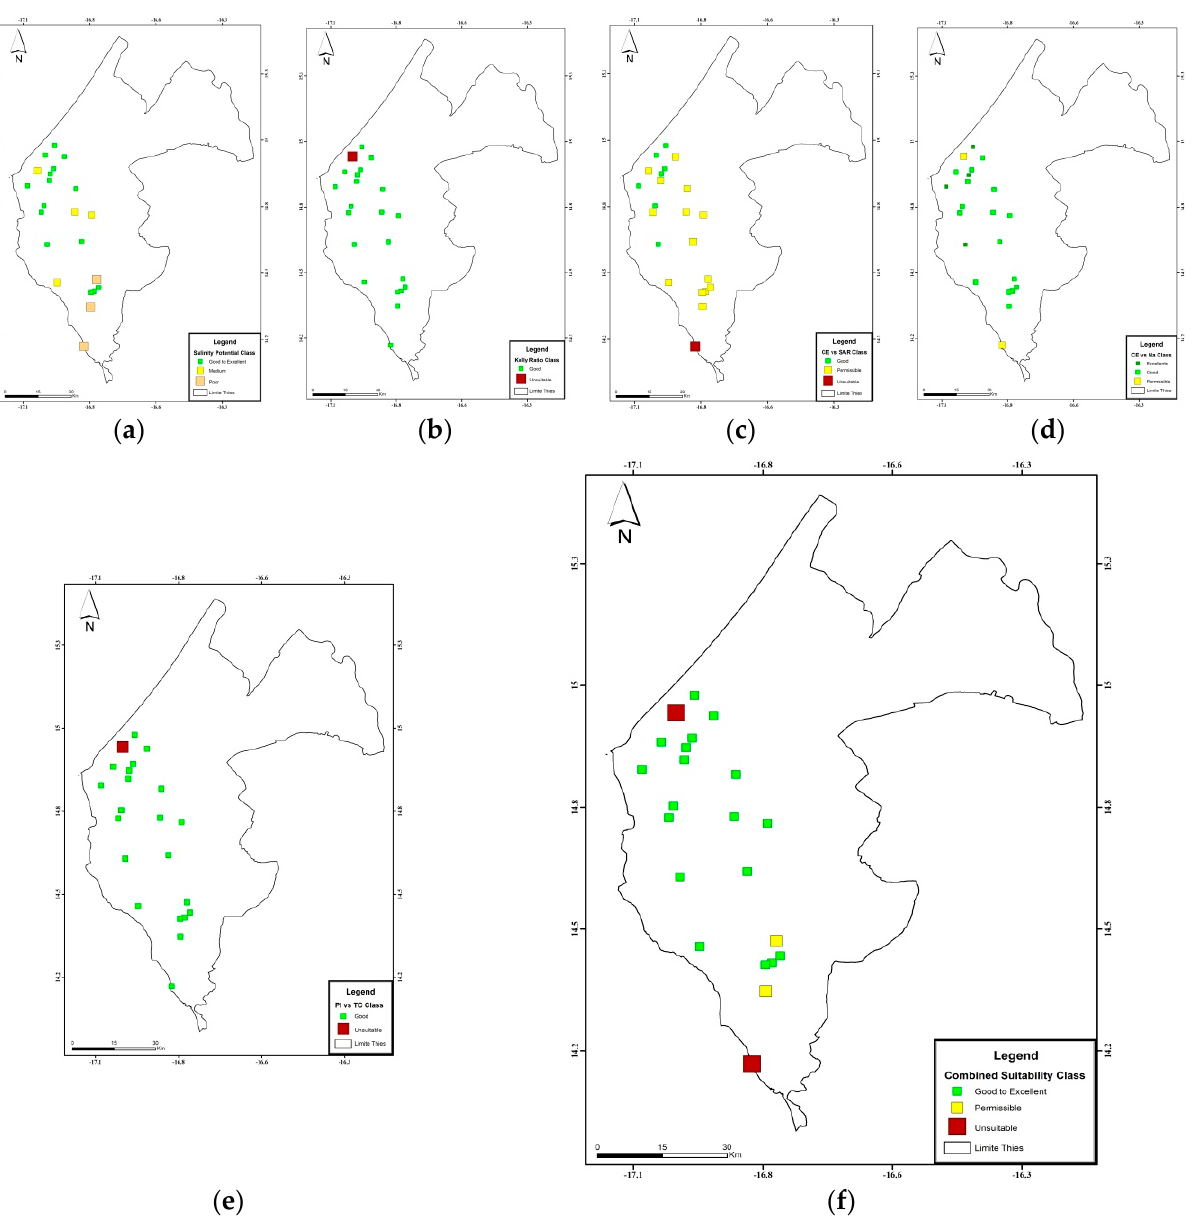
Figure 8. Salinity potential ( a ), Kelly ratio ( b ), CE vs. SAR ( c ), CE vs. Na% ( d ), PI vs. TC ( e ), and combined ( f ) suitability maps of Paleocene aquifer for irrigation purpose.